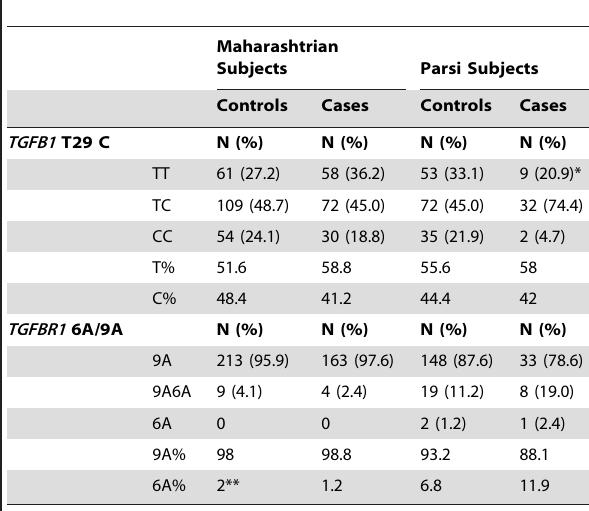
Table 2. Frequencies of TGFB1 T29C and TGFBR1 6A/9A genotypes in the study